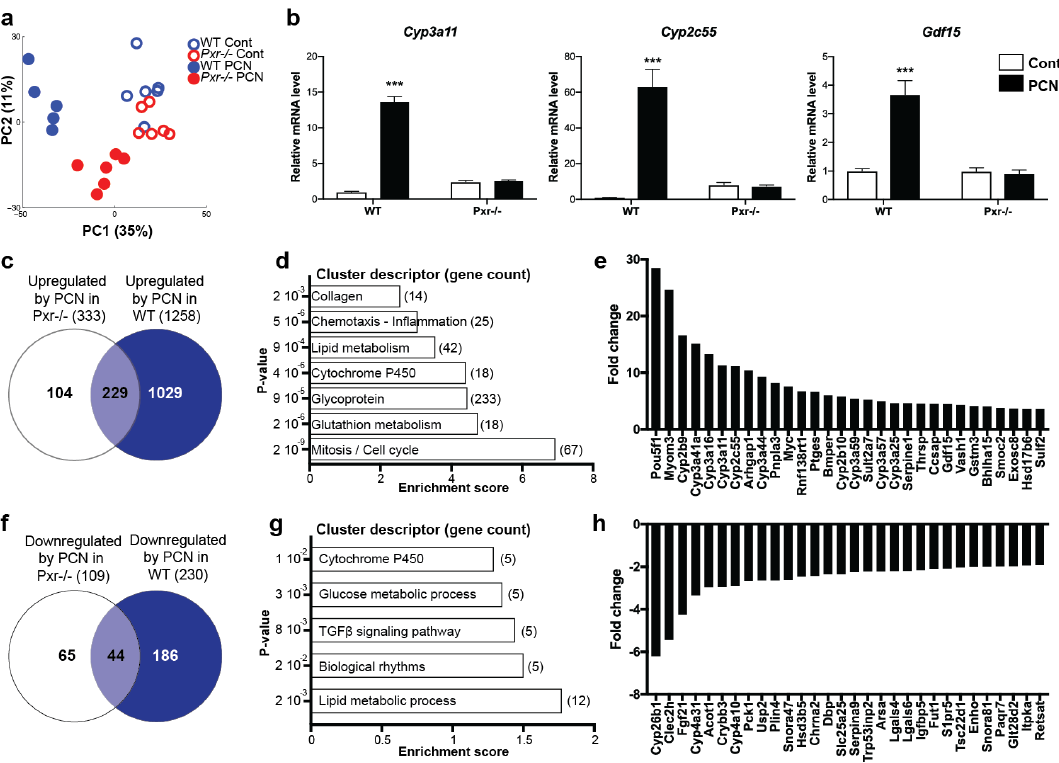
Figure 1. Effect of pregnenolone 16α-carbonitrile (PCN) treatment on liver parameters ( a ) and plasma biochemistry ( b ). Data are shown as mean ± SEM of n = 5–6 per group. * p ≤ 0.05, ** p ≤ 0.01, *** p ≤ 0.005 for PCN effect using 2-way ANOVA and Tukey’s post-tests. $ p ≤ 0.05 for genotype effect. ALT: Alanine amino-transferase; FFA: Free fatty acids.